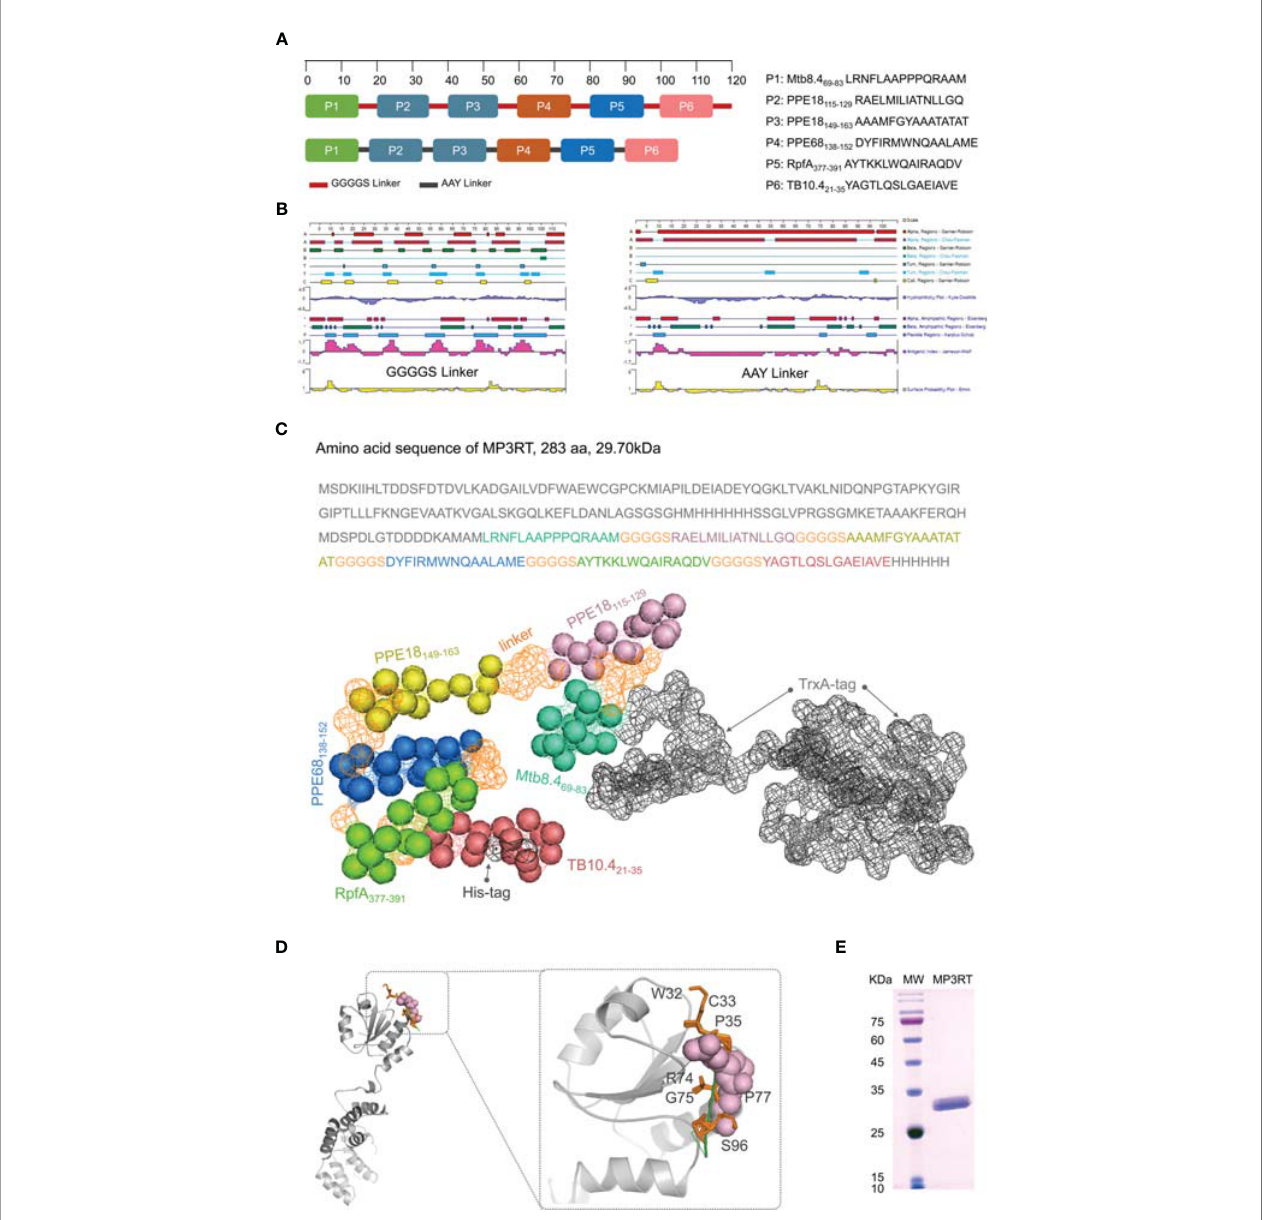
FIGURE 3 | Construction and structural prediction of MP3RT vaccine. Six immunodominant peptides were linked with GGGGS or AAY linkers in silico (A) . Their antigenic index, surface probability, hydrophobicity, alpha regions, beta regions, and turn regions were assessed using Lasergene Protein software (B) . The length and molecular weight of MP3RT were 283aa and 29.70 kDa, respectively (C) . The 3D structure of MP3RT was presented in Cartoon, Space fi ll, and Surface (C, D) . The MP3RT vaccine was prepared in E. coli cells and veri fi ed with polyacrylamide gel electrophoresis (E)